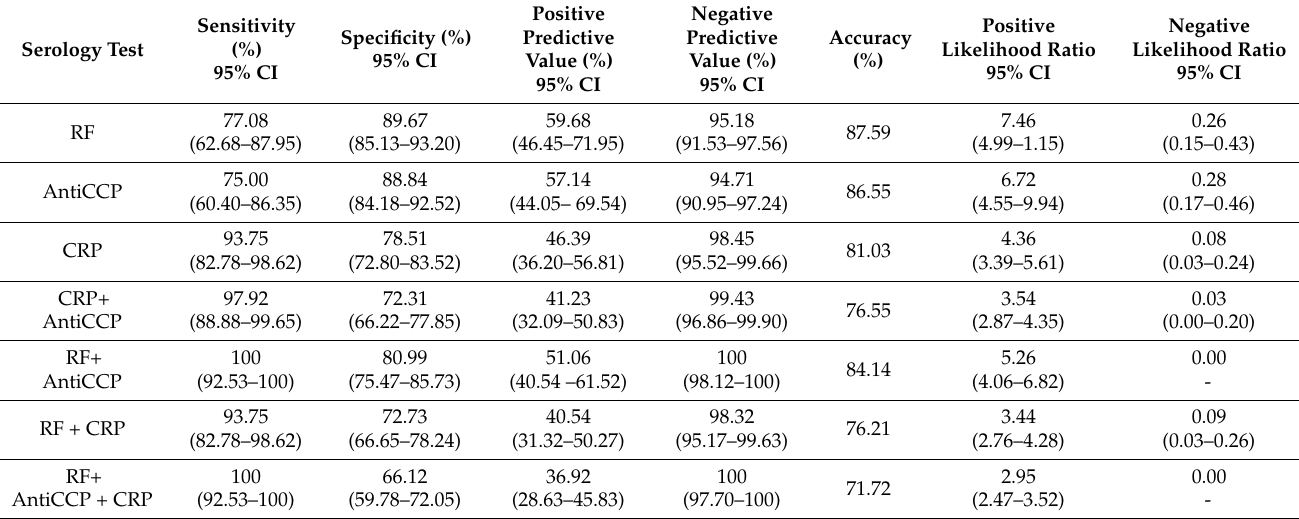
Table 5. Sensitivity, specificity, PPV, NPV, LR+ and LR −